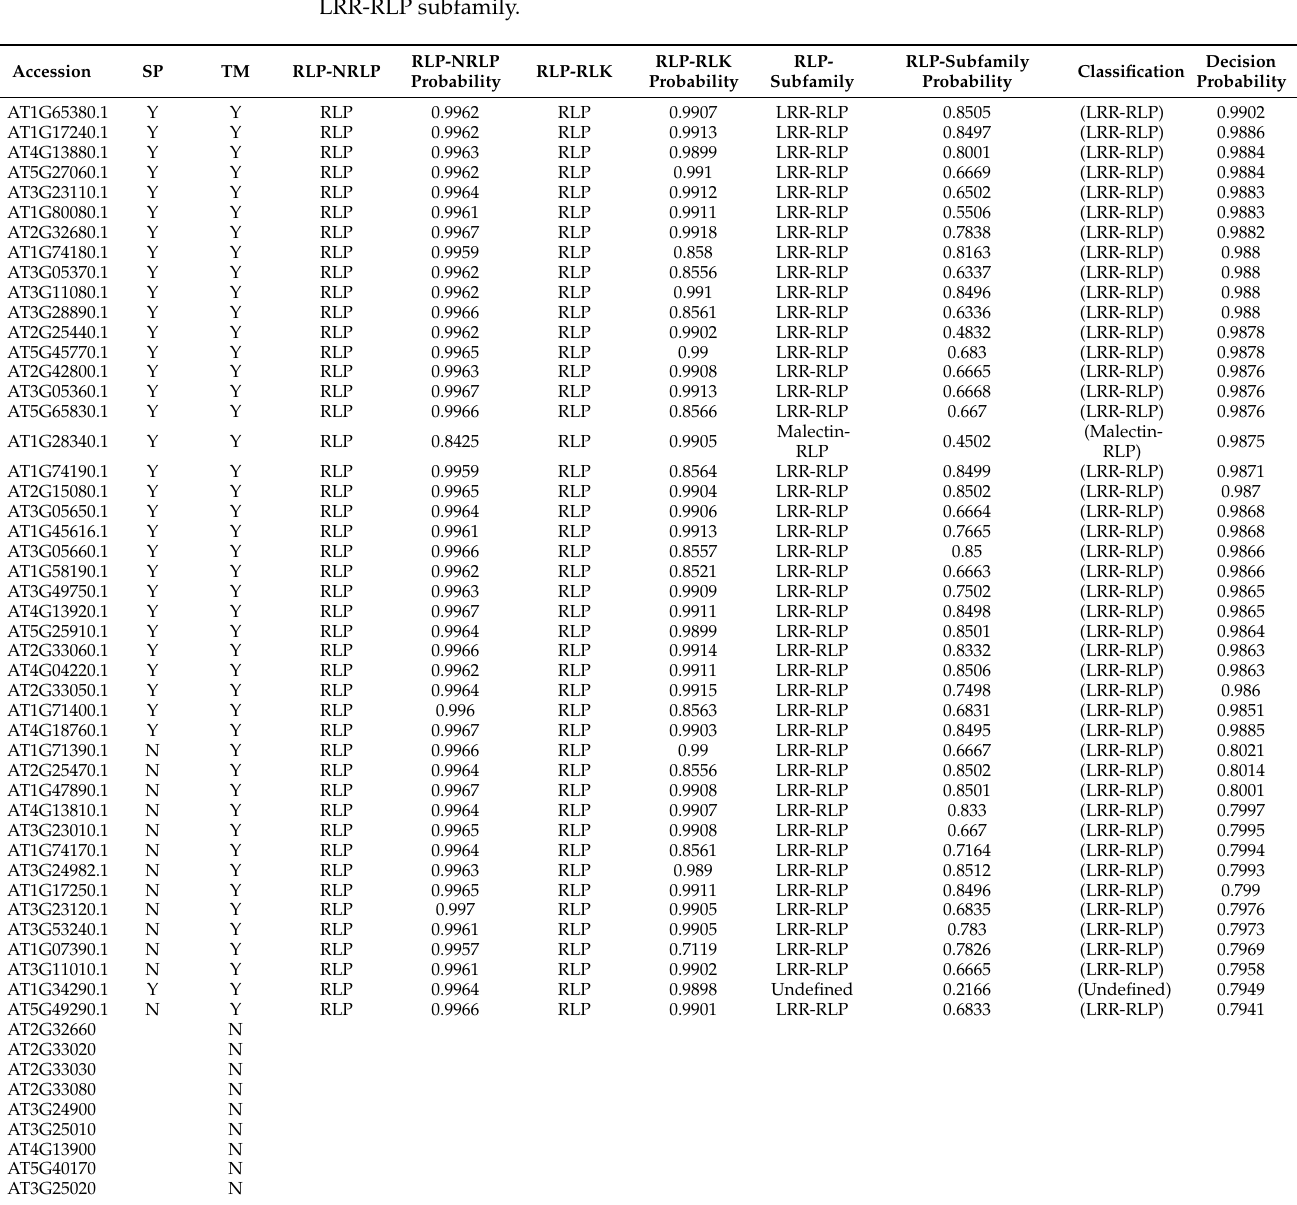
Table 7. Validation of the RLPs from the genome-wide study of Arabidopsis RLPs restricted to the LRR-RLP